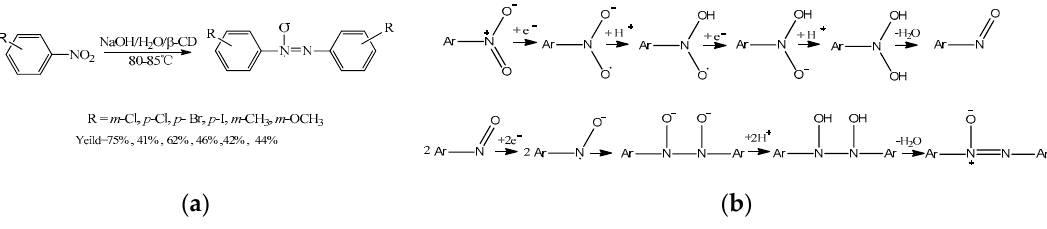
Scheme 9. ( a ) The reduction reaction of nitrobenzene catalyzed by β -CD; ( b ) the proposed mechanism pathways of nitrobenzene reduction.